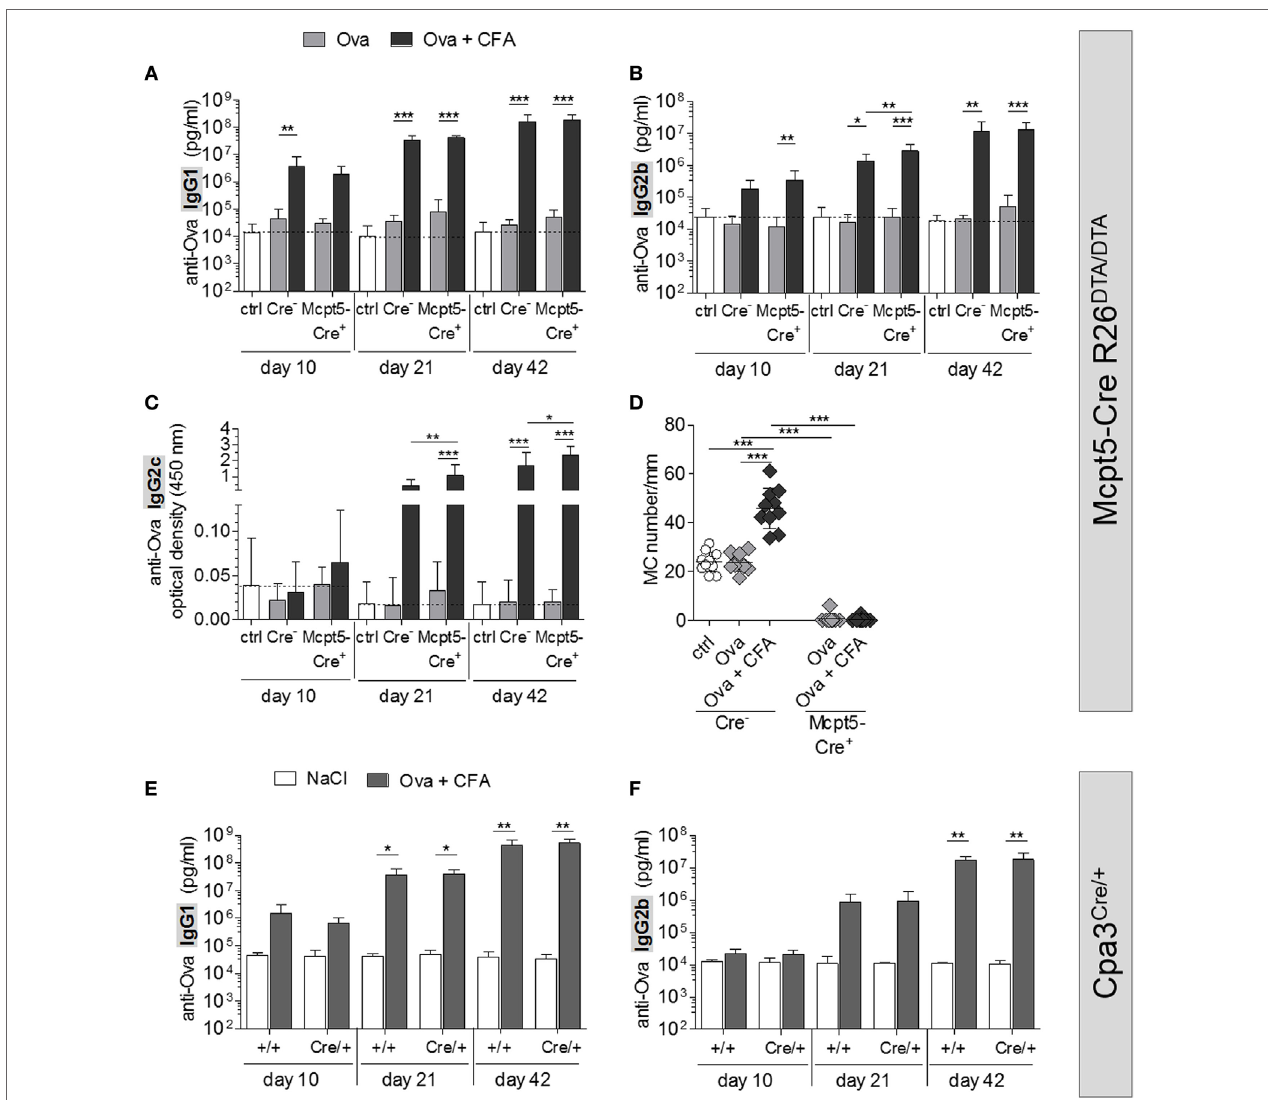
FigUre 3 | No impairment of humoral immune responses in mast cell (MC)-deficient mice. (a–c) Quantification of anti-Ova IgG1 (a) , IgG2b (B) , and IgG2c (c) by ELISA in the serum of saline treated Cre -controls ( n = 12) and MC-deficient Mcpt5-Cre + R26 DTA/DTA mice and Cre -negative littermates immunized intradermally with Ova alone or Ova plus CFA (Ova alone Cre + n = 10, Cre − n = 10; Ova plus CFA Cre + n = 11, Cre − n = 10). Two independent experiments were performed and yielded similar results. (D) MCs were counted in Giemsa-stained sections of tail base skin samples taken from each animal represented in (a–c) at day 42 after immunization per 20 mm length of epidermis. Means ± SD are shown. In all cases, statistical analysis was performed using one-way ANOVA and Bonferroni’s multiple comparison test. (e,F) Quantification of anti-Ova IgG1 (e) and IgG2b (F) by ELISA in the serum of saline treated controls ( Cpa3 + / + n = 4, Cpa3 Cre/ + n = 3) and MC-deficient Cpa3 Cre/ + mice and MC-proficient Cpa3 + / + littermates immunized intradermally with Ova plus CFA ( n = 7 both groups). A single experiment was